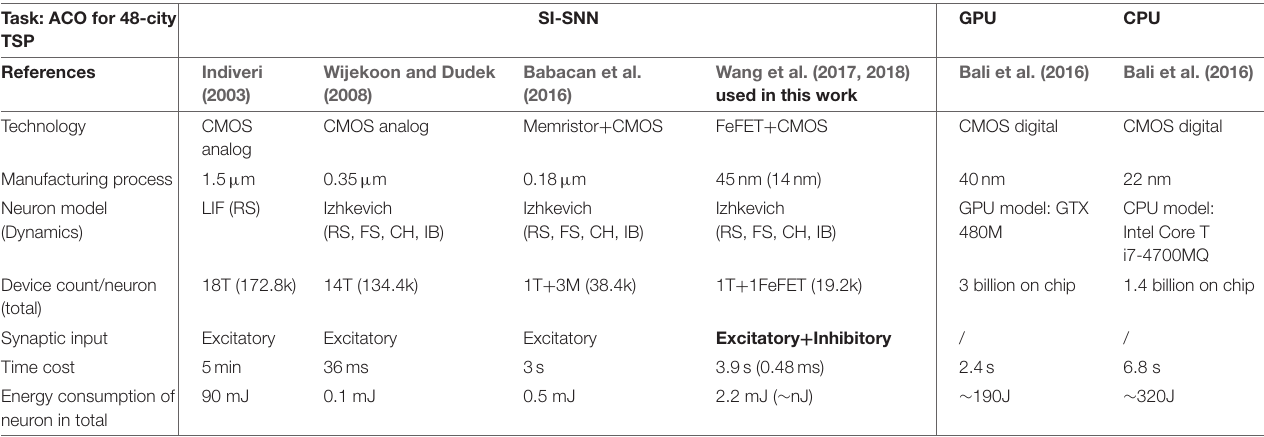
TABLE 3 | Comparison of proposed computing paradigm and other methods. Task: ACO for 48-city